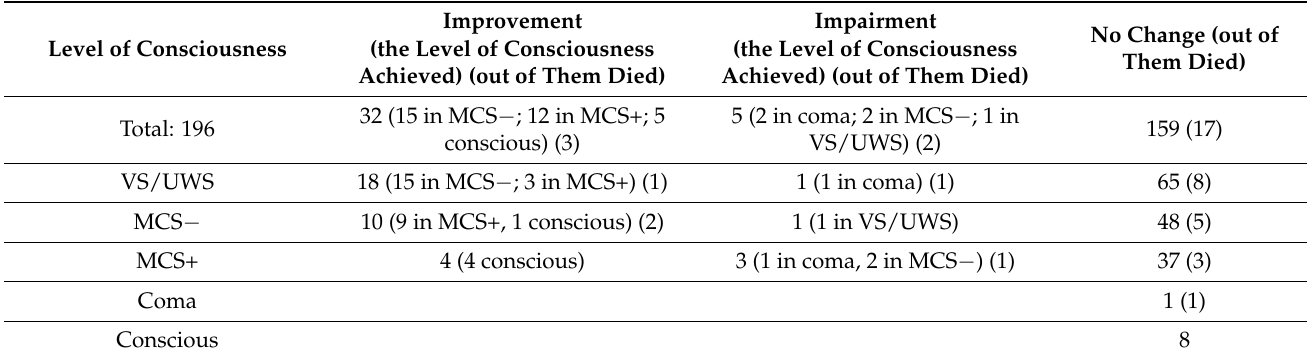
Level of Con- Table 5. Changes in the level of consciousness at the 6 month checkpoint.